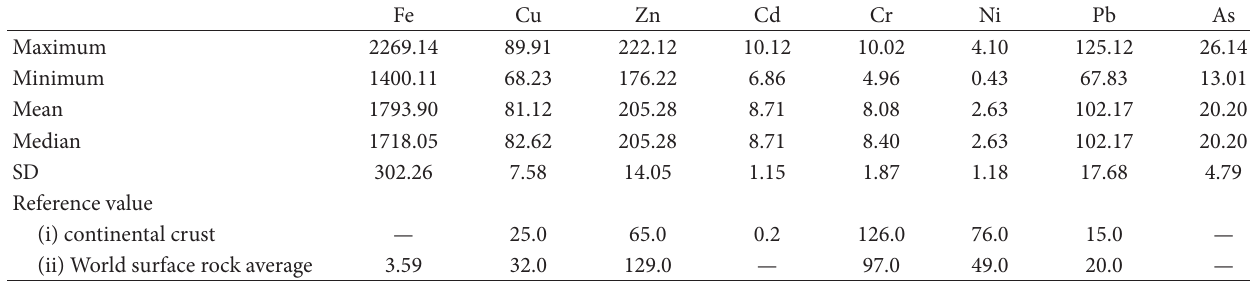
T 5: Statistics of the determined element in soil samples (